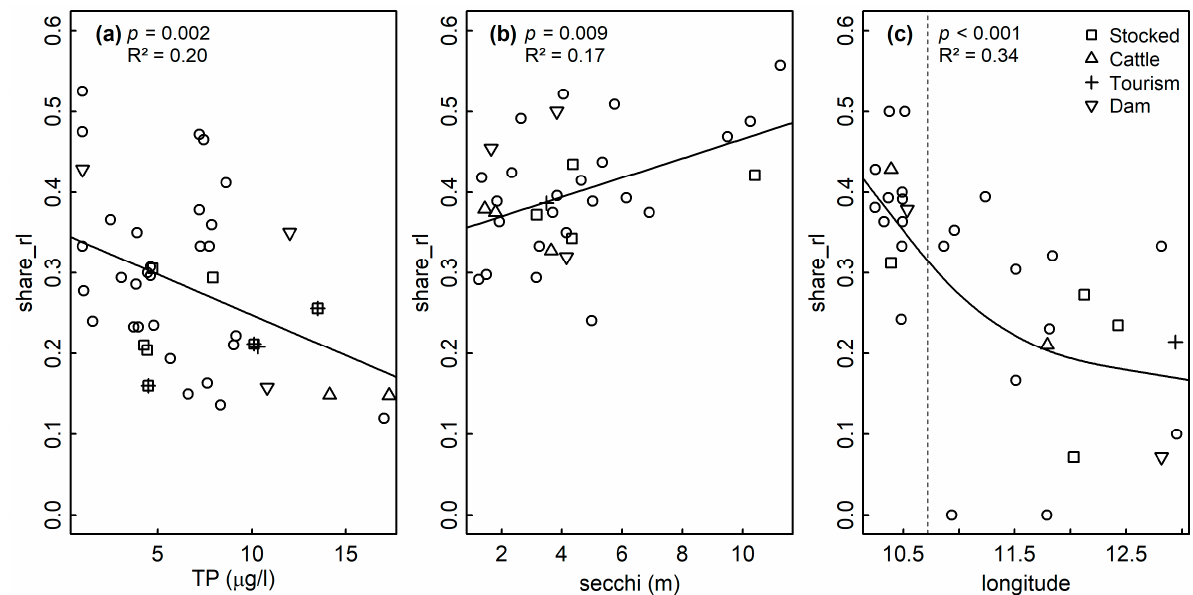
Figure 4. A significant correlation was detected based on LMs between the share of RL species (share_rl) and total phosphorous (TP) and Secchi depth (secchi) for ( a ) sedimentary and ( b ) littoral assemblages, respectively. A significant decrease of share_rl with longitude (lon) was found for planktic assemblages ( c ) based on GAMs.